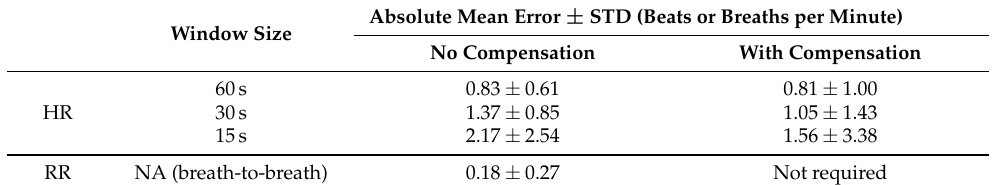
Table 4. HR/RR calculation descriptive statistics (k-means algorithm for HR and simple thresholding for RR) showing mean absolute error and standard deviation (STD) of the absolute error.